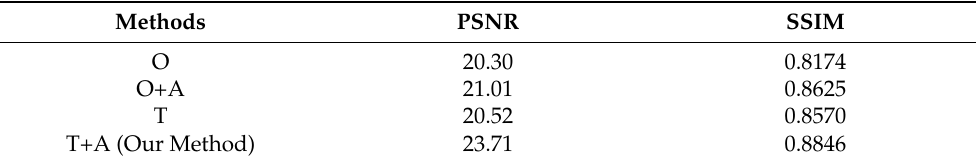
Table 2. Quantitative evaluation results between each part and the whole